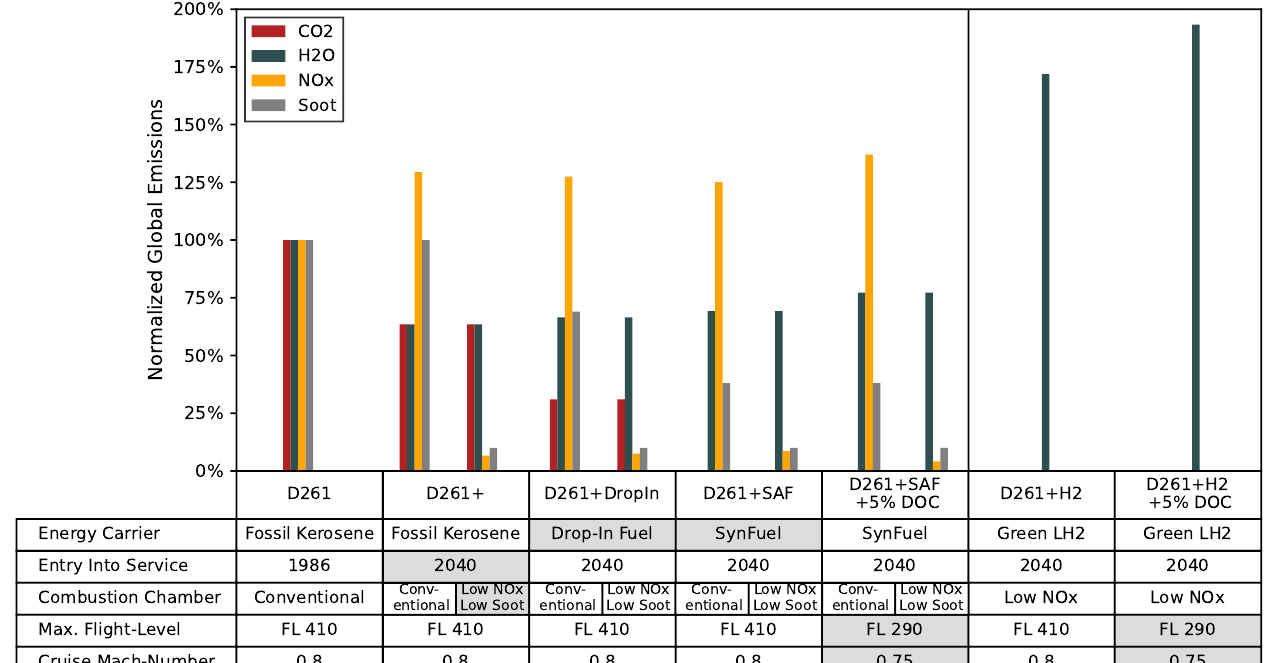
Figure 15. Relative global changes in emissions with conventional and advanced low-NO x and low-soot combustion. The grey cells indicate the changes of the new scenario compared with the preceding